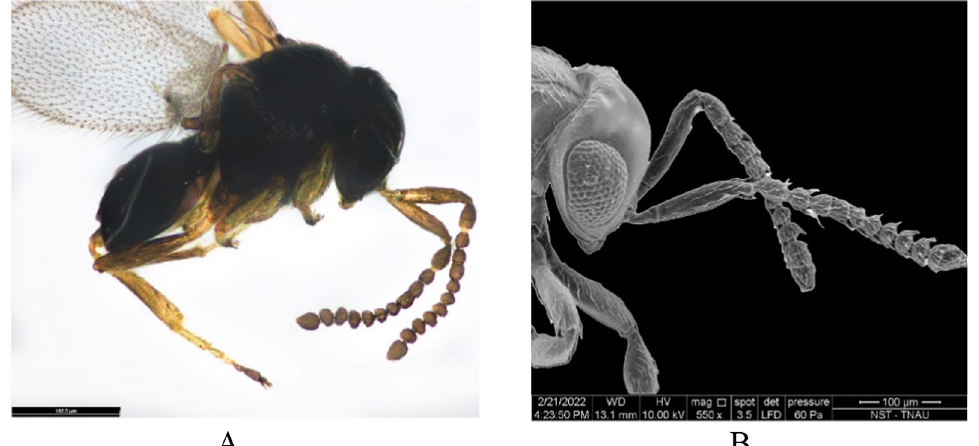
Fig. 17 A, B Geniculate antenna of male T.